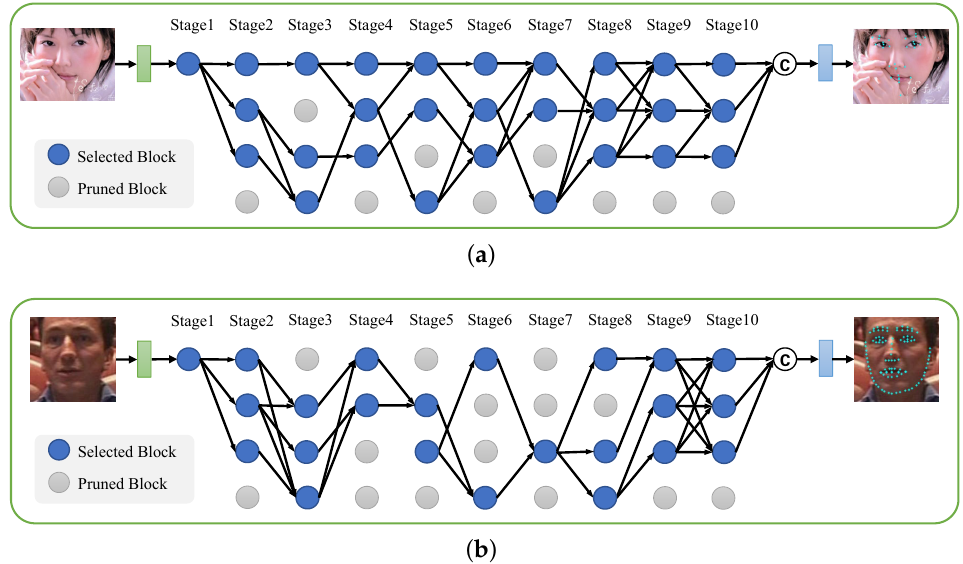
Figure 7. Visualization of the slimmed architectures trained on the COFW ( a ) and WFLW ( b )